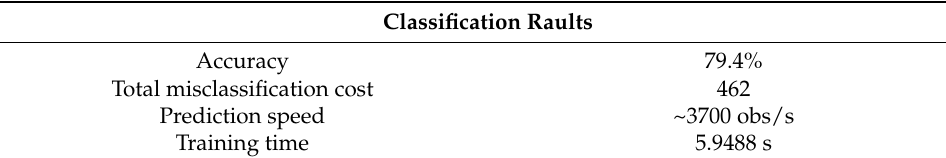
Table 15. Classification results for thin samples based on transmission mode.